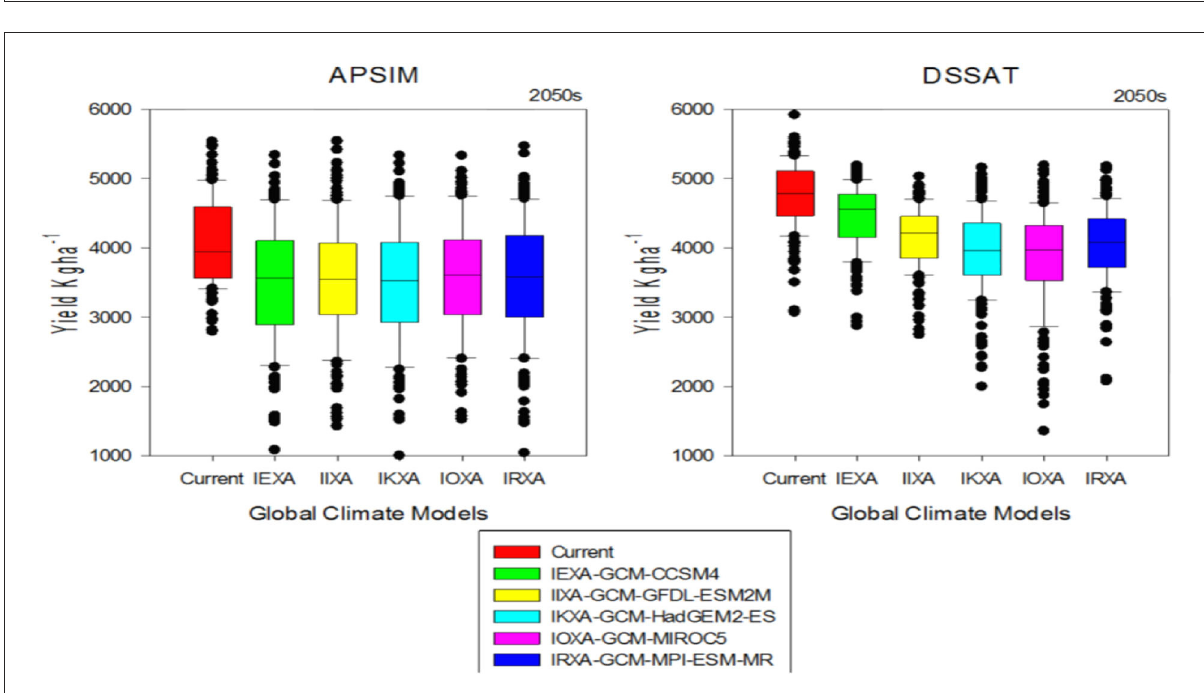
FIGURE8 Reduction in wheat yield of APSIM and DSSAT models for 155 farms; variation with 5-GCMs in rice-wheat cropping system of